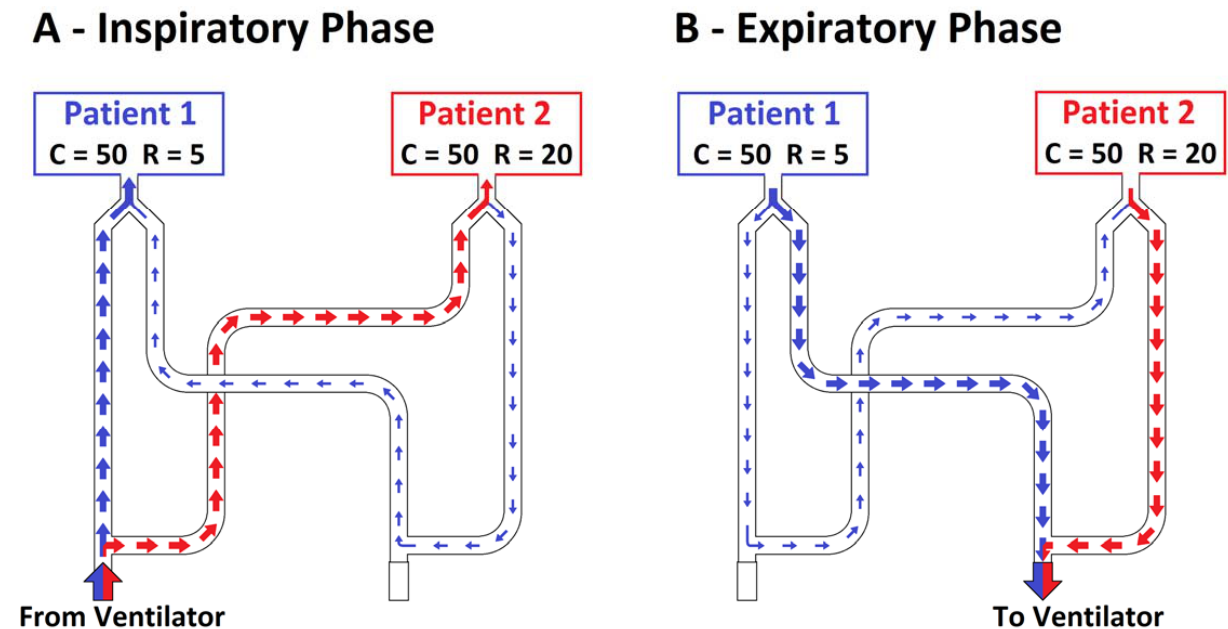
Figure 4. Flows across the custom-made circuit on setting C 50-50/R 5-20 during the inspiratory time ( A ) and the expiratory time ( B ). Blue = patient 1, red = patient 2. Circuit and arrows in figure are not to scale.